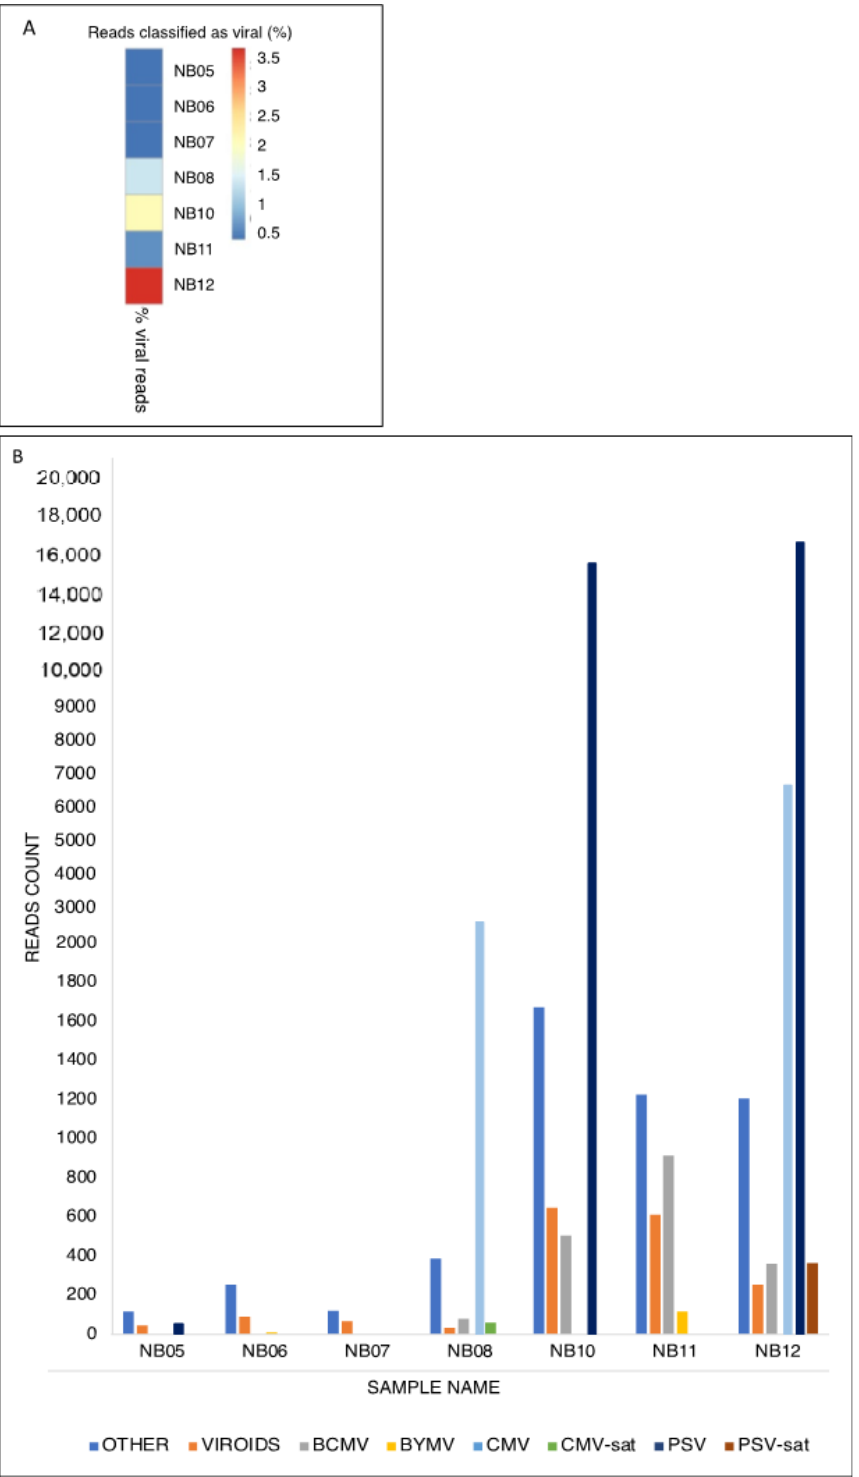
Figure 2. ( A ) Proportion of viral reads produced by HTS sequencing (Oxford Nanopore Technologies). For each sample, the proportion of reads with a hit in the viral database is reported; ( B ) Virome composition. Bars represent relative abundance of viral species for each sample. Only reads with a hit in the viral database are considered. BCMV = bean common mosaic virus; BYMV = bean yellow mosaic virus; CMV = cucumber mosaic virus; CMV sat. RNA = cucumber mosaic virus satellite RNA; PSV = peanut stunt virus; PSV sat. RNA = peanut stunt virus satellite